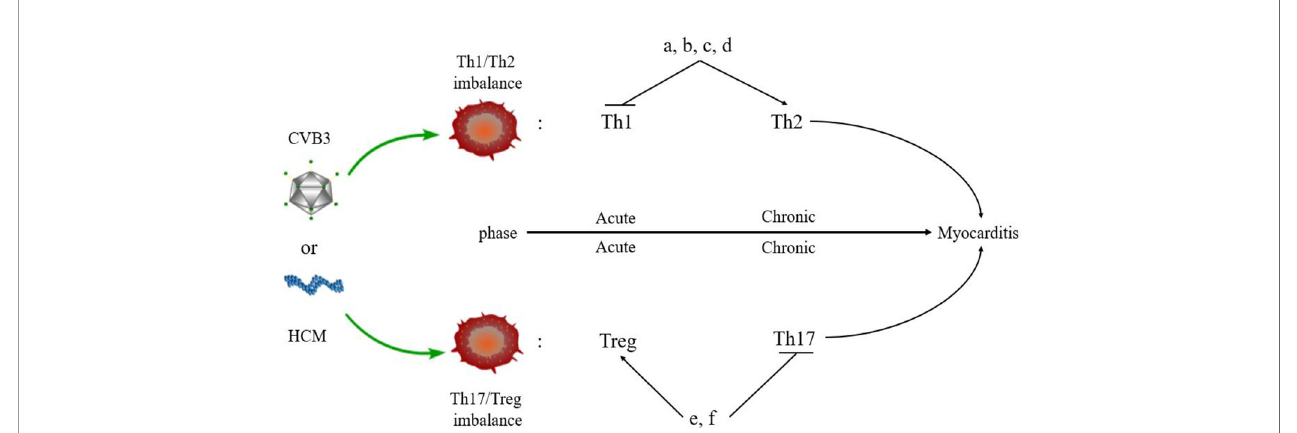
FIGURE 3 | Myocarditis and Th responses. An imbalance of Th cells is observed in the pathogenesis of myocarditis. Th1 and Treg cells are predominant in the acute phase of myocarditis, while Th2 and Th17 cells dominate the chronic phase of myocarditis. Some drugs regulate the balance of Th cells in myocarditis. (A) Atorvastatin; (B) Tanshinone IIA; (C) Apigenin; (D) Cyclooxygenase-2 inhibitors; (E) . Valproic acid; (F) Feno fi